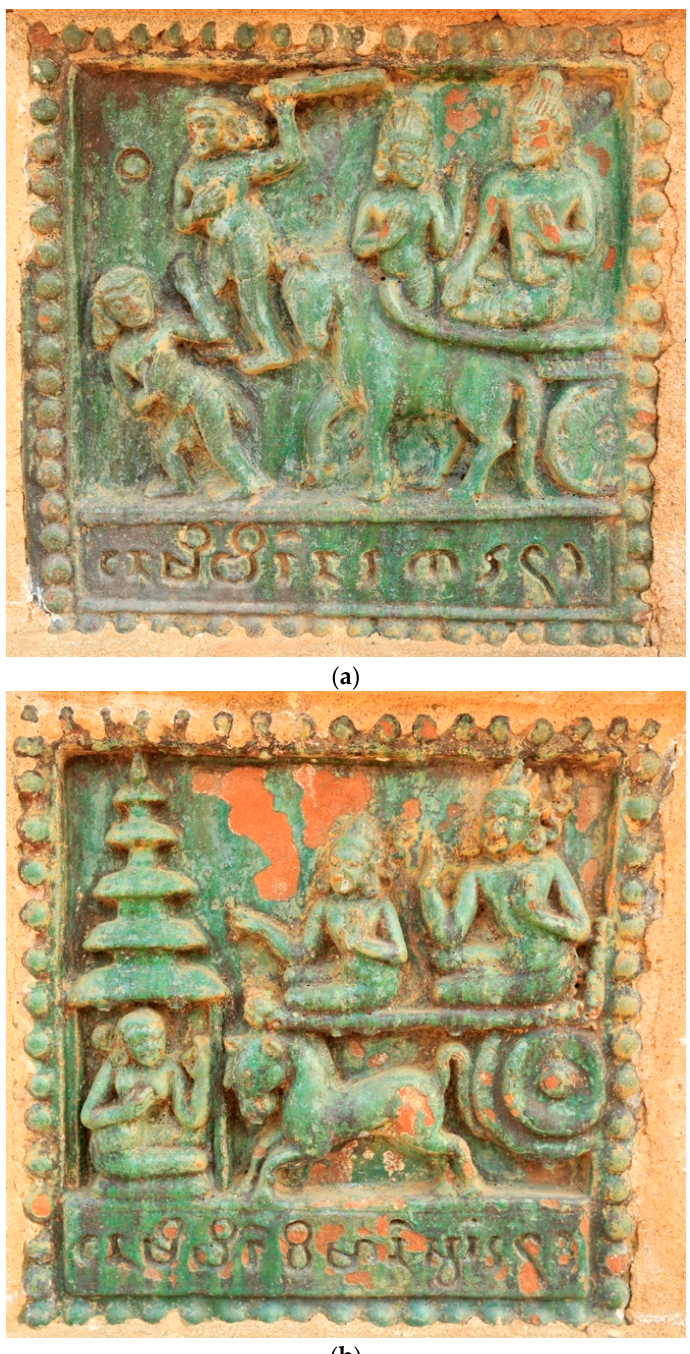
Figure 36. Pagan, Ananda, 11th century. Nimi J ā taka. ( a ) Nimi visits hells., ( b ) Nimi visits a devi in her vimana.